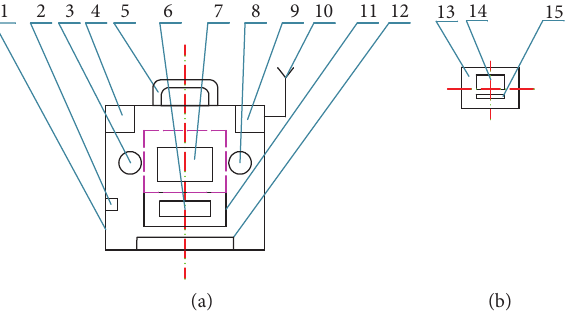
Figure 14: Intelligent recognition device of miss-fire detonators and miss-fire explosives in shaft construction. (a) Portable recognition host of miss-fire detonators and miss-fire explosives; (b) flexible recognition label. (1) Shell; (2) data interface; (3) sound alarm device; (4) alarm module; (5) portable device; (6) control panel; (7) LED display module; (8) light alarm module; (9) communication module; (10) antenna; (11) mainboard; (12) battery module; (13) flexible pastable body; (14) chip motherboard; (15) external identification.